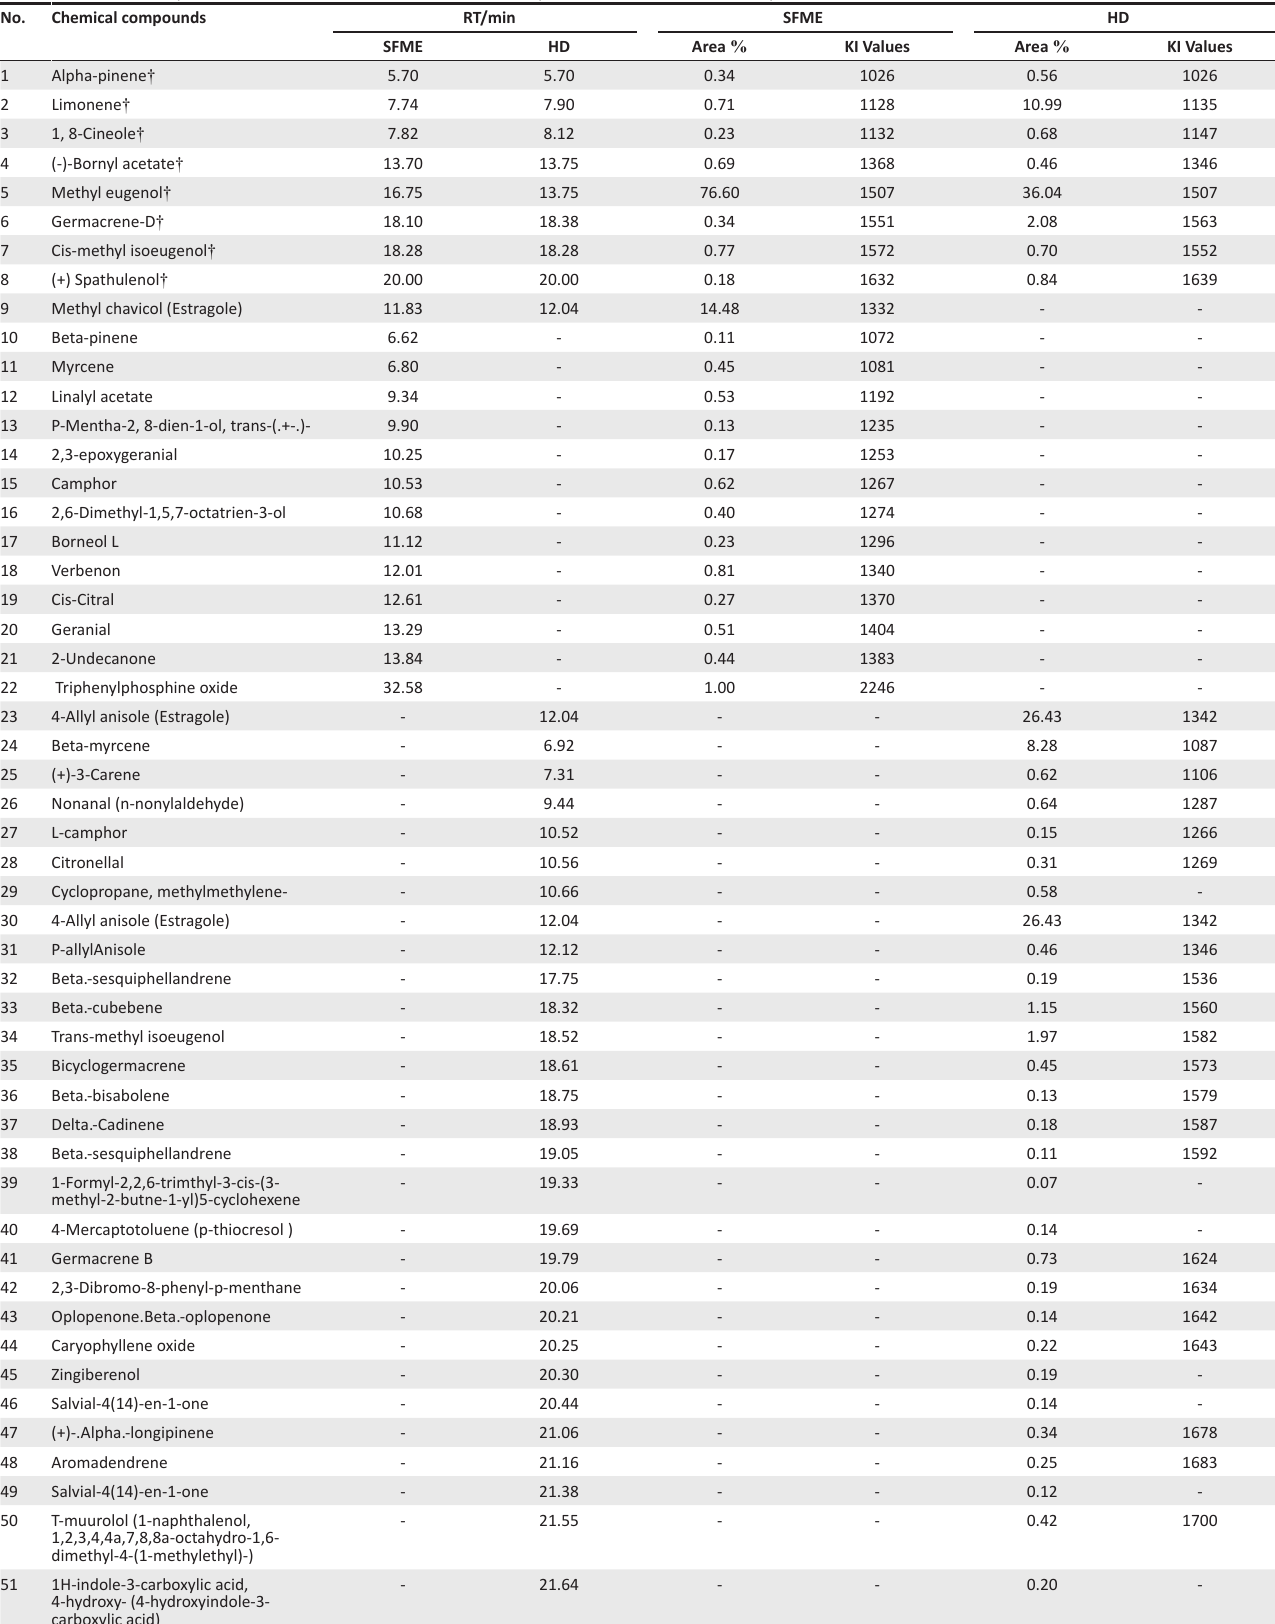
TABLE 1: Chemical composition of essential oil of C. anisata obtained by solvent-free extraction and hydrodistillation.